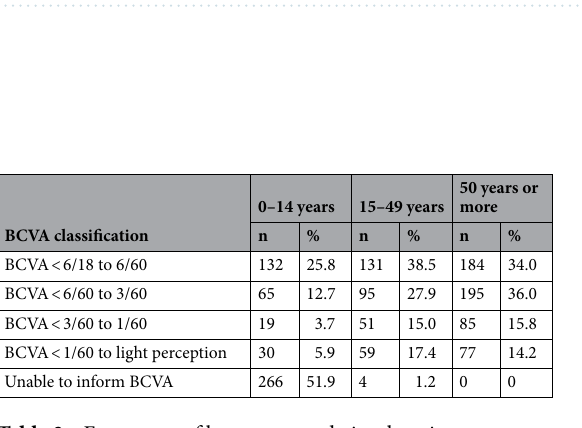
Table 2. Frequency of best-corrected visual acuity per age group studied (n = 1393). n number of subjects, BCVA best-corrected visual